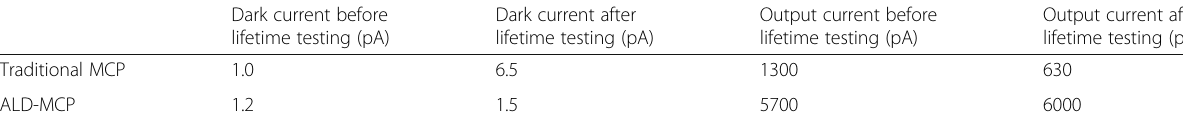
Table 2 Dark current and output current measured before and after lifetime testing Dark current before lifetime testing